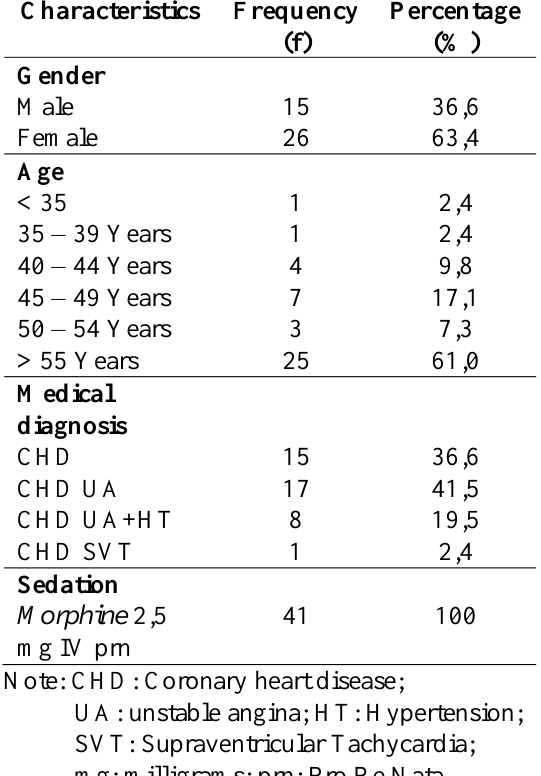
Table 1. Characteristics of Respondent (n=41)